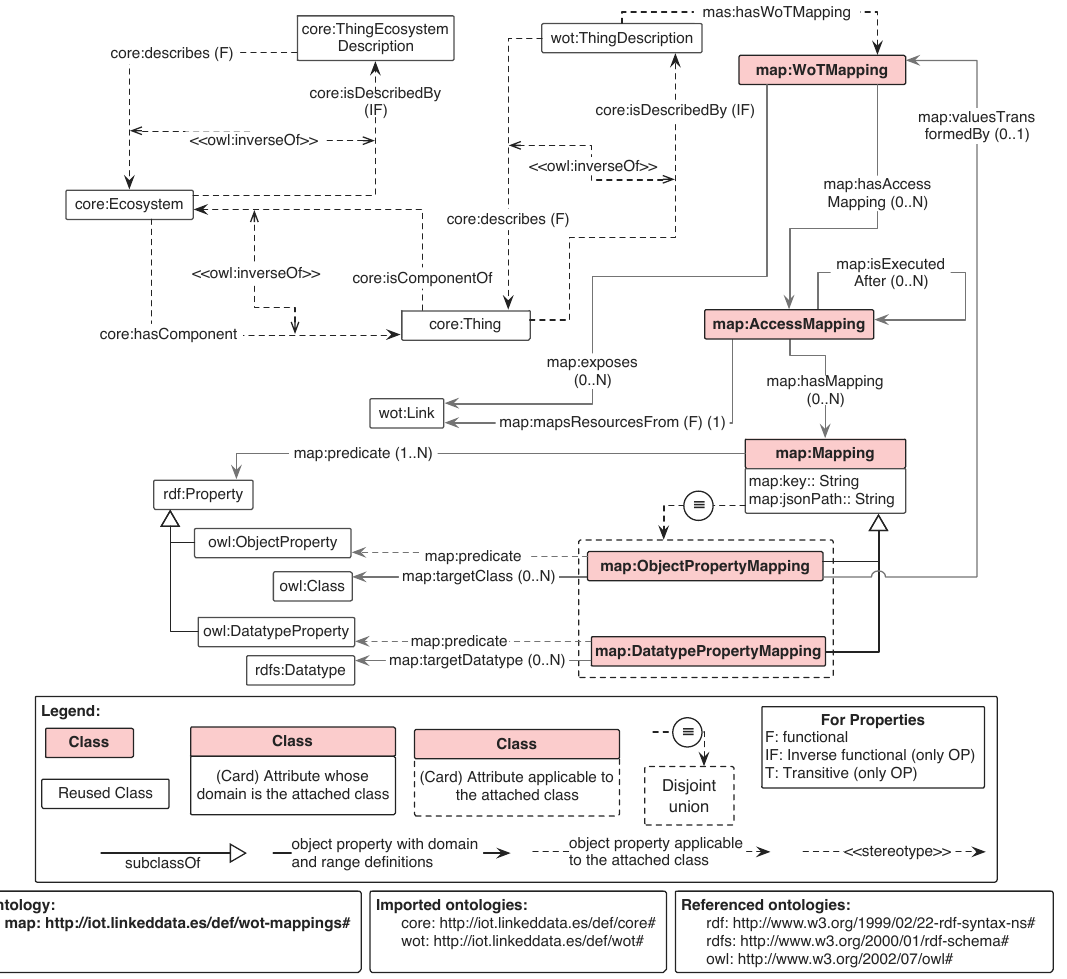
Figure 2. General overview of the WoT-Mapping